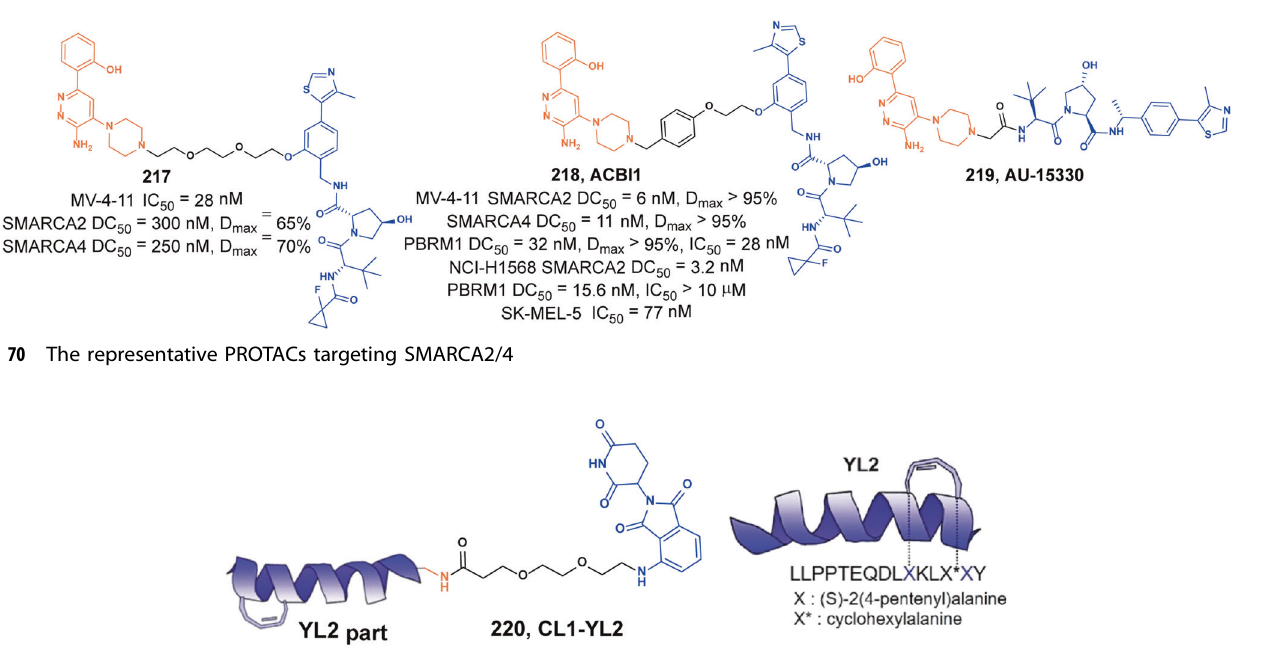
Fig. 71 The representative PROTAC targeting SRC-1